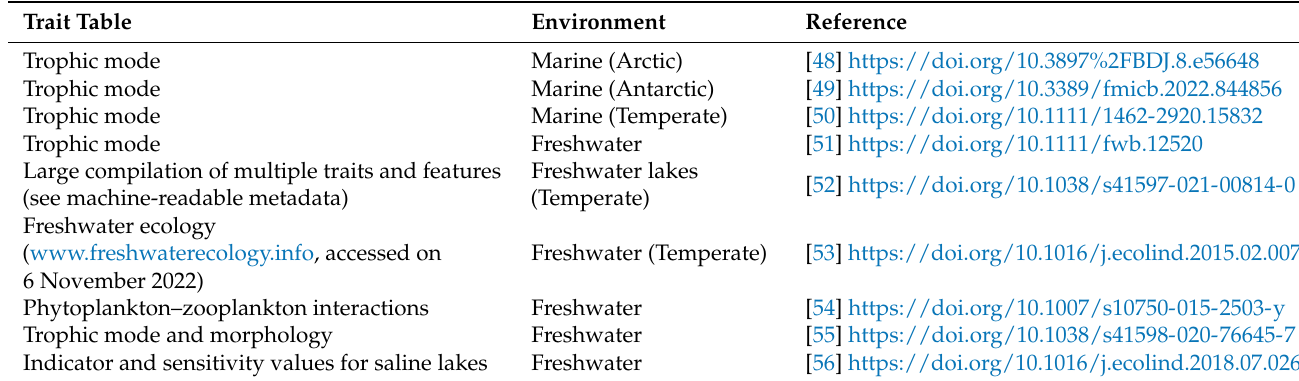
Table 1. Existing phytoplankton trait tables